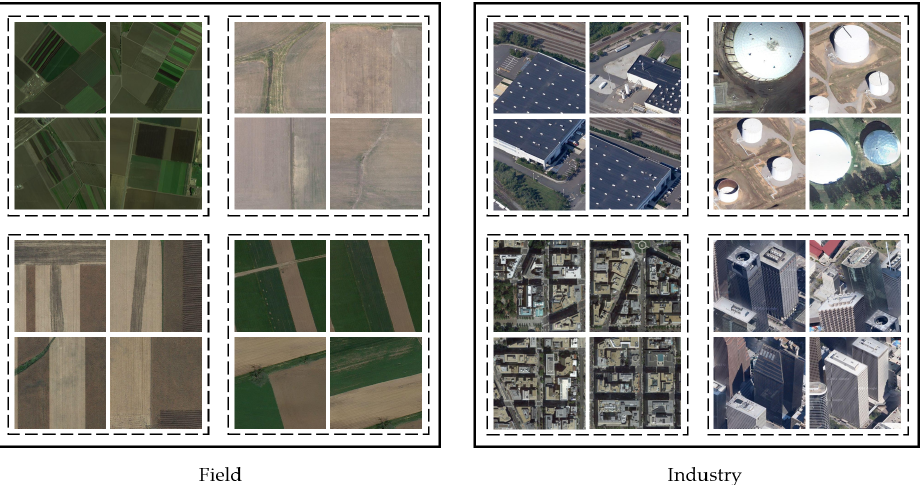
Figure 1. Intra-class differences and aggregation on RSSCN7. The solid boxes show the images of the field and the industry class, respectively. It can be found that in the same class, the features of samples in the same dotted box are similar, while the features of samples in different dotted boxes are relatively